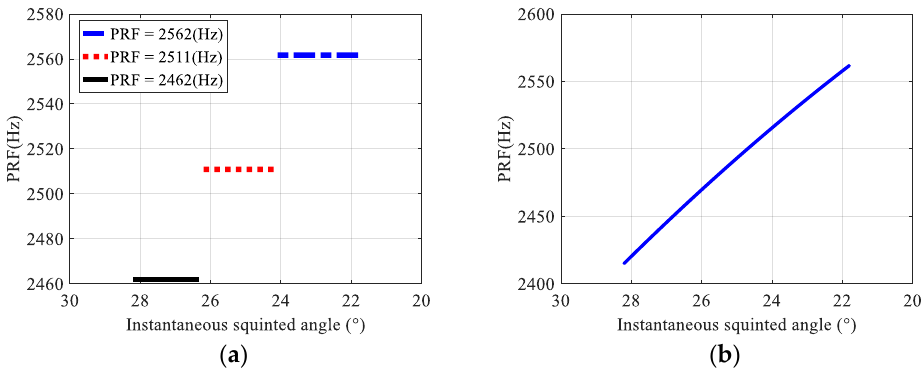
Figure 5 . Design results of BV-PRF and CV-PRF. ( a ) BV-PRF; ( b ) CV-PRF. Figure 5. Design results of BV-PRF and CV-PRF. ( a ) BV-PRF; ( b ) CV-PRF.